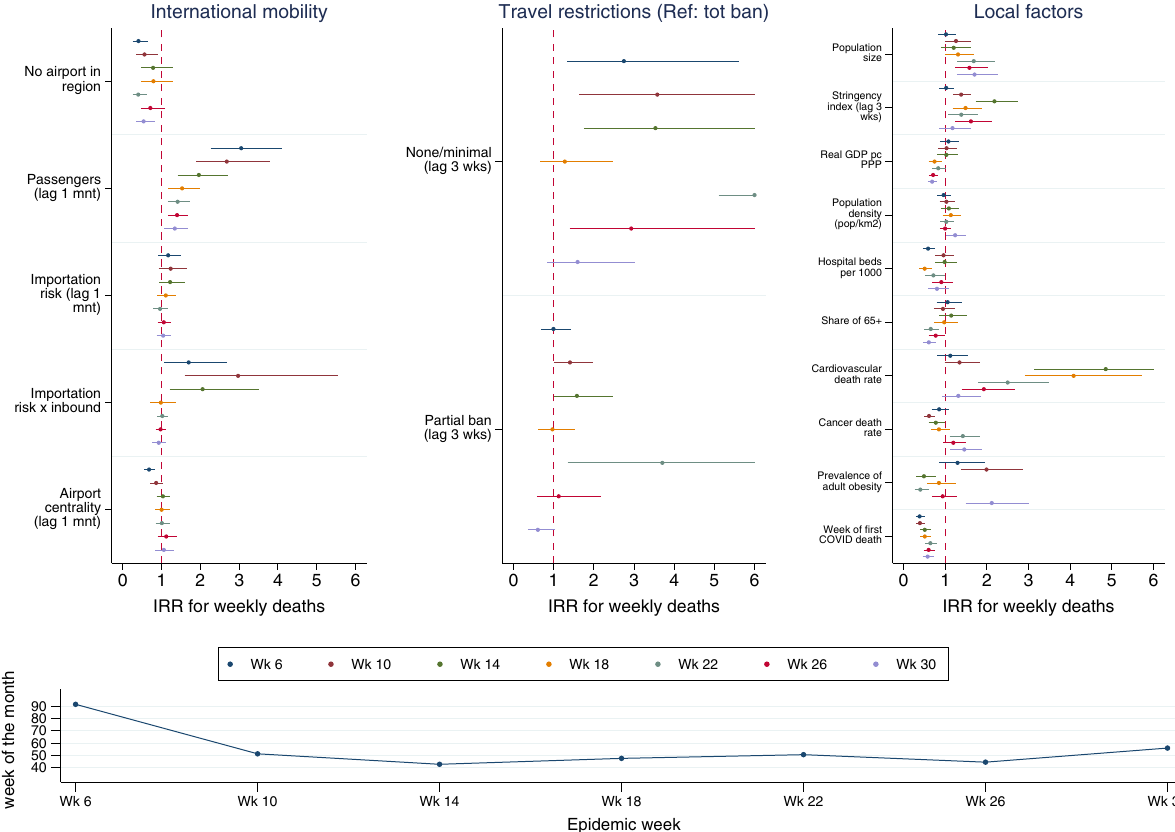
Figure 4. The impact of air passenger traffic on the severity of COVID-19 deaths in the first 30 epidemiological weeks (week1 = first COVID-19 death) controlling for population mixing (NPI), structural predispositions and recursive effects. Negative binomial regressions with fixed effects by continent. Risk ratios and confidence intervals. For full model specifications with coefficients, see Table C4 in Supplementary Information. Source : Sub-National COVID-19 Incidence and Determinants